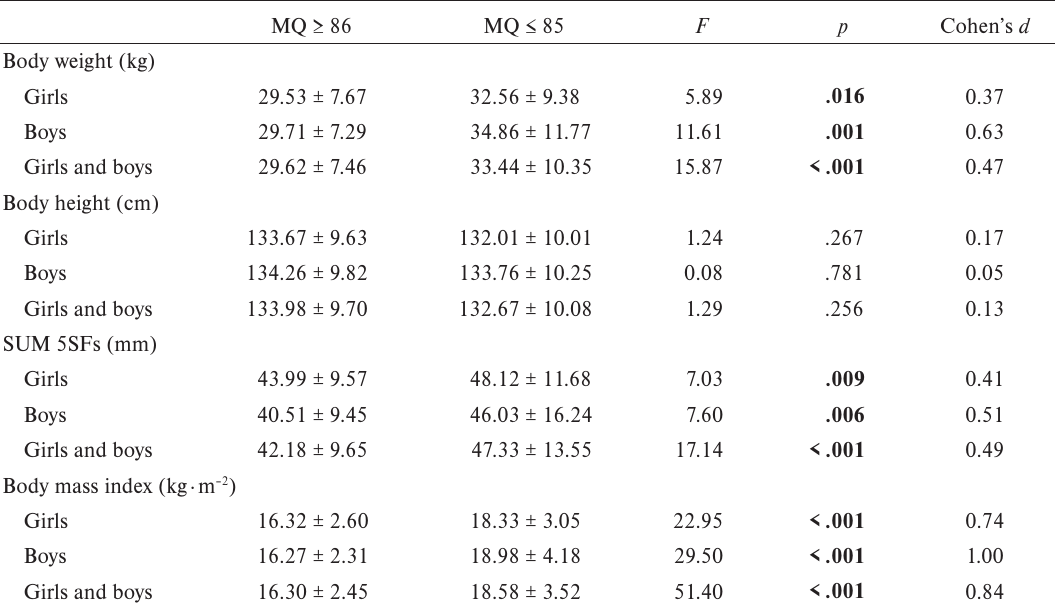
Comparison of anthropometric indicators (presented as M ± SD) in the group of girls and boys aged 7 to 10 years (N = 436) from the point of view of MQ